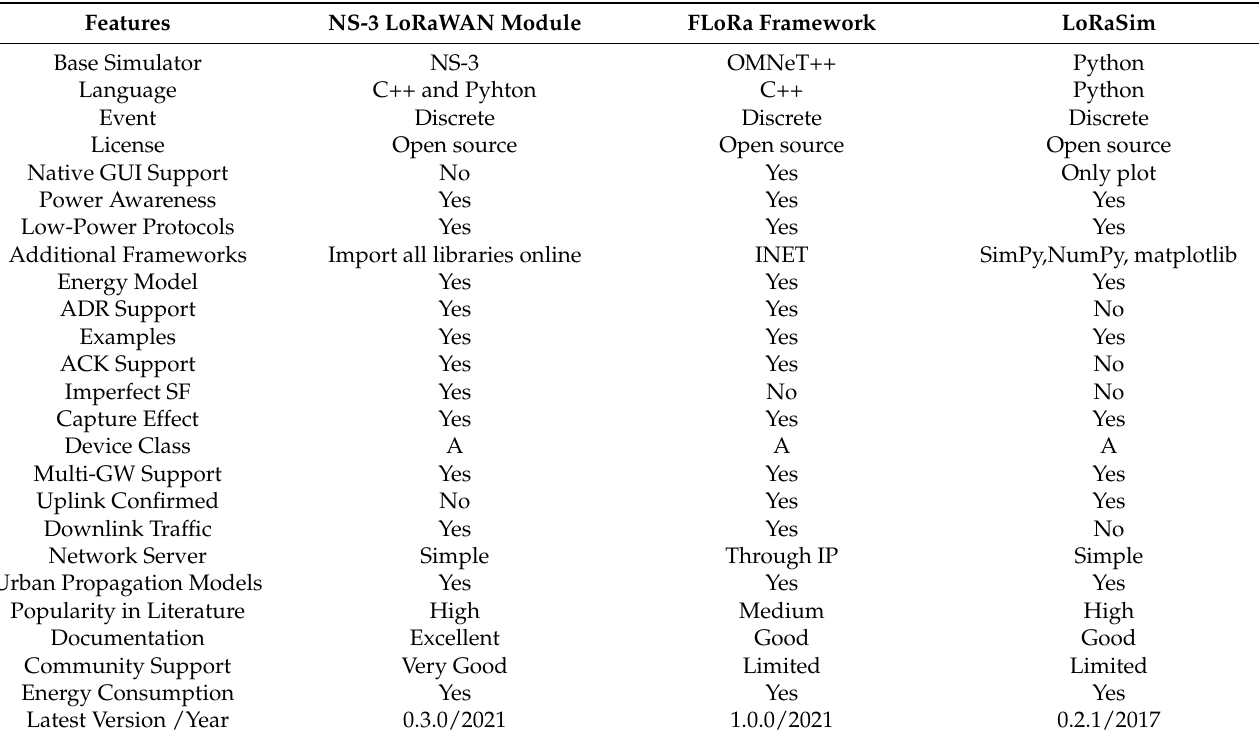
Table 9. Comparison of NS-3, FLoRa and LoRaSim Simulation Tools with focus on LoRa/ LoRaWAN